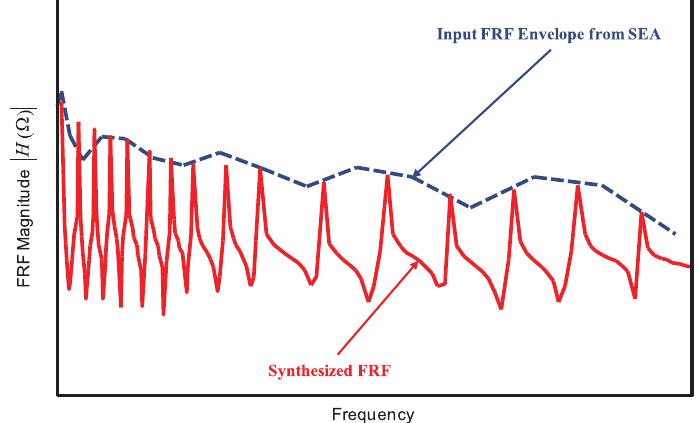
Fig. 2. FRF synthesis by using the FRF envelope from